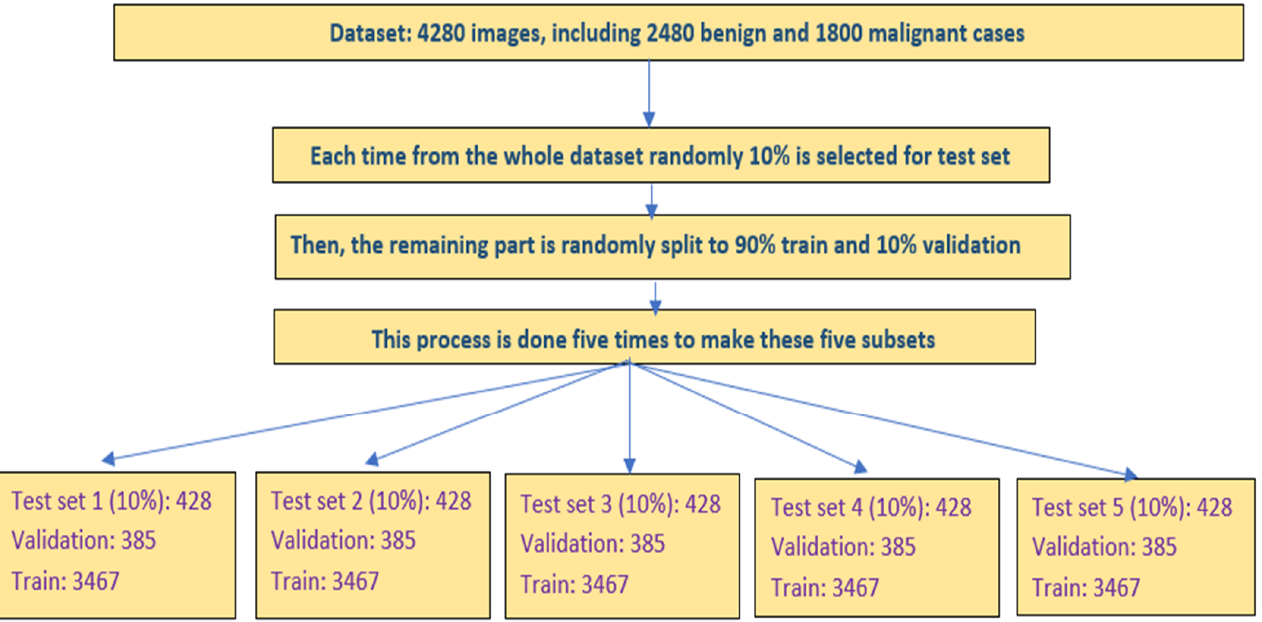
Figure 7. Schematic diagram of model training, validation, and testing phase.